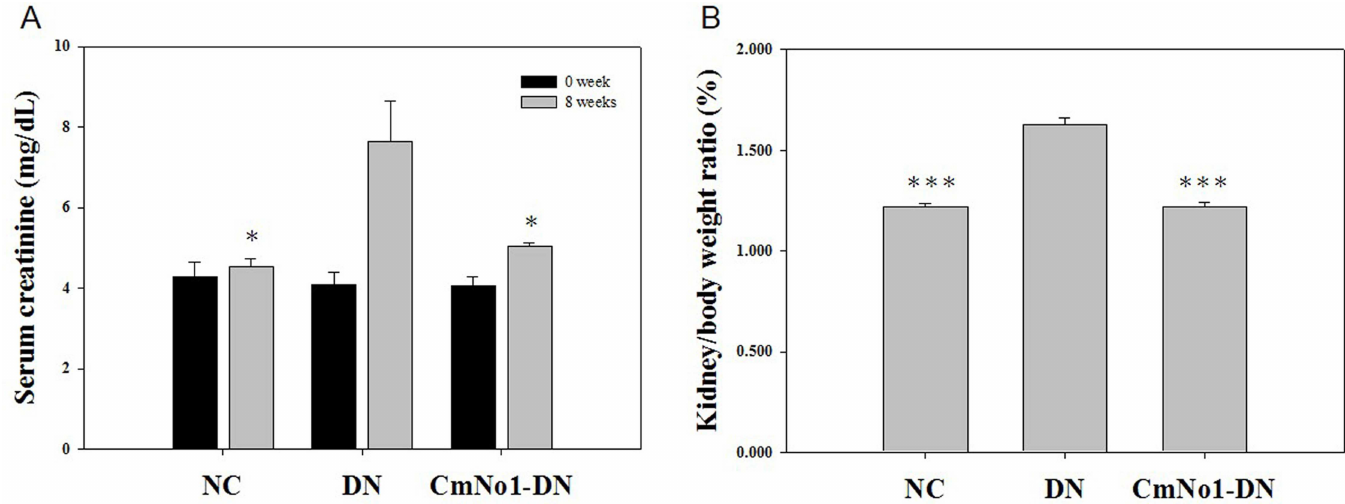
Fig 2. Efficacy of CmNo1 on kidney dysfunction markers. (A) Serum creatinine (B) Weight ratio of kidney to body (KW/BW). Data are expressedas mean ± SEM (NC, n = 5; DN, n = 6; CmNo1-DN, n = 6). Symbols specify significantdifference from DN with * and *** indicate p < 0.05 and p < 0.001, respectively. NC: Normal control; DN: Diabeticnephropathy; CmNo1-DN: Diabeticnephropathygroup mice treated with Cordyceps militaris No1.